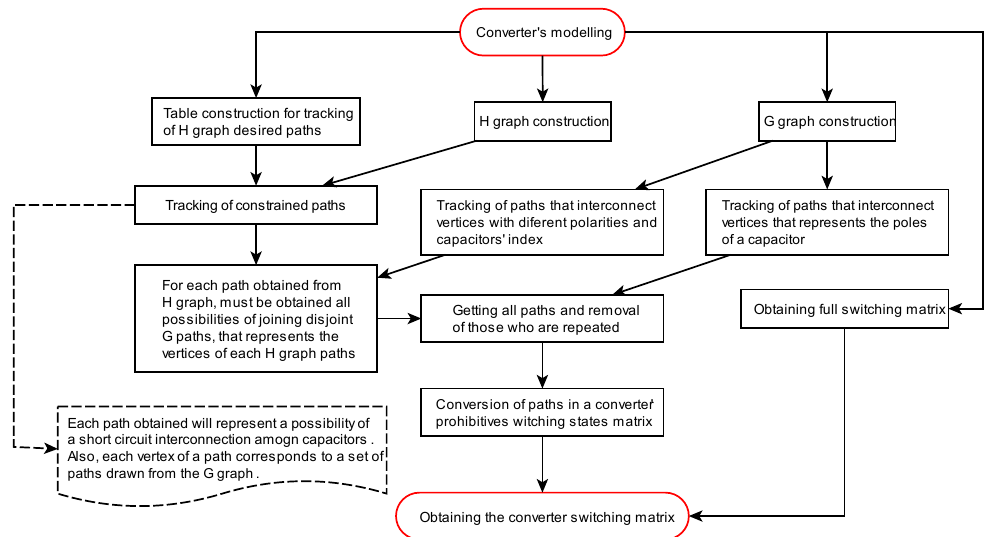
Figure 8. Flowchart of a methodology based on graph theory to identify prohibitive states of CHB-B2B converters’ switching